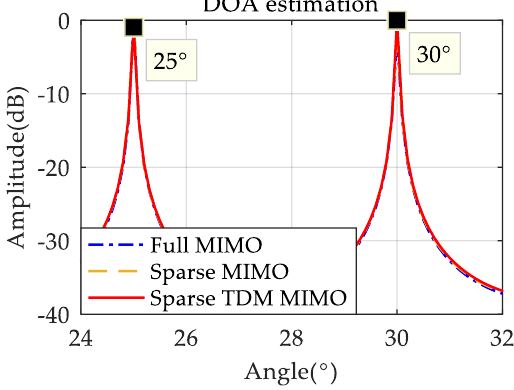
Figure 7. DOA performance for static targets.